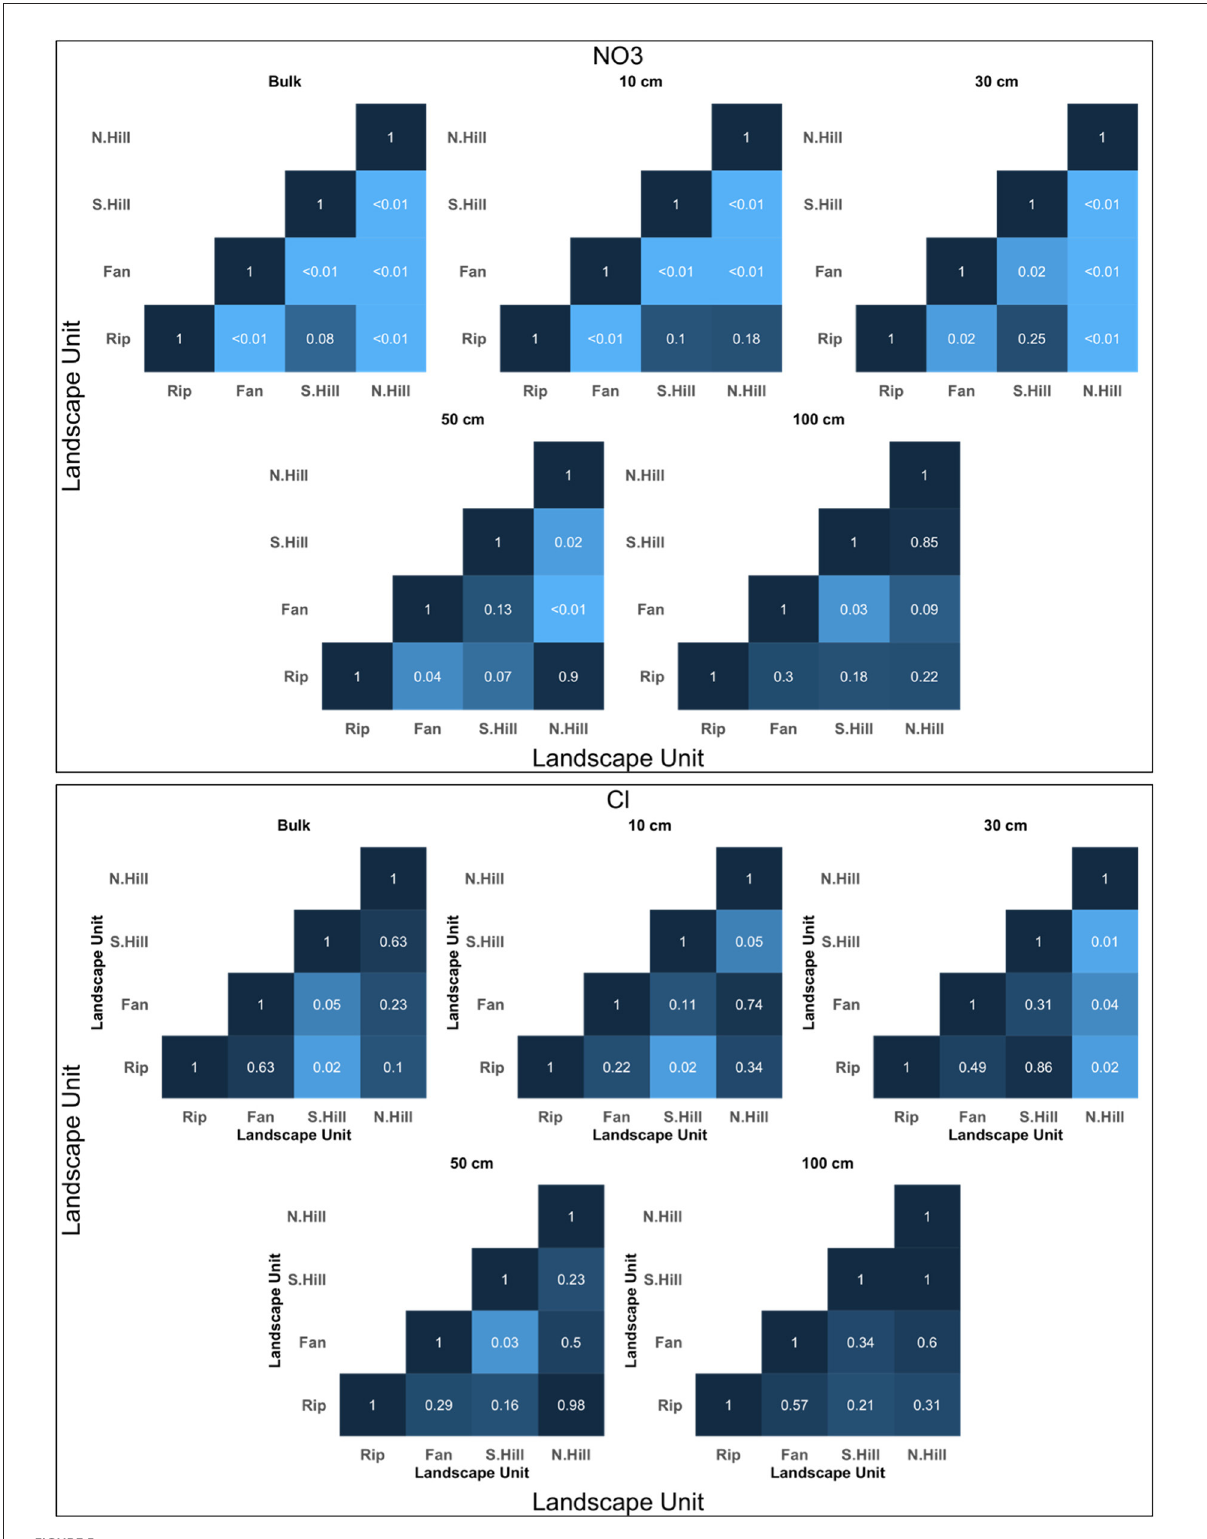
FIGURE5 Significance matrices for t- test comparisons of anions among different landscape units at each depth. The shade of the comparison is dependent on the level of significance, with lower p- values being lighter, and higher p -values being darker. Matrices shown are limited to solutes which were used for molar ratio